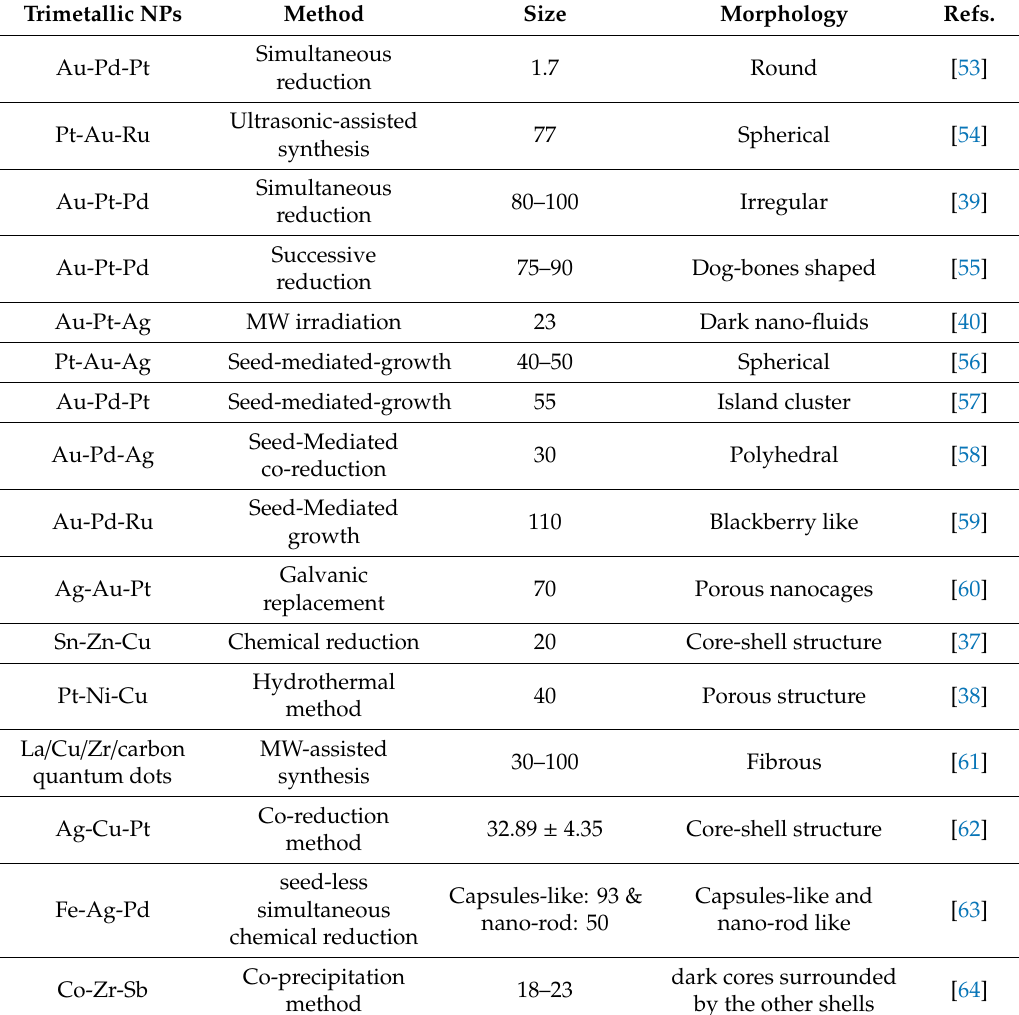
Table 1. Some important examples of the synthesized trimetallic NPs by various